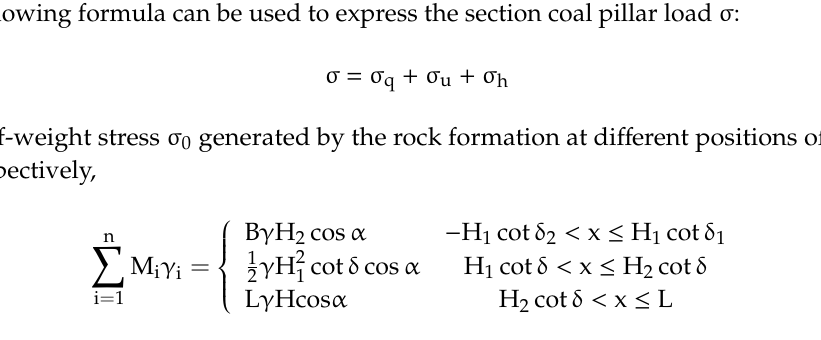
Figure 2. Geological model of coal pillar load.